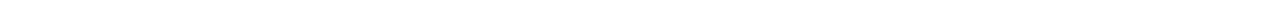
Fig. 7 Enhanced representation of target stimuli in a range of auditory Go/No-Go tasks. Each line of four panels represent the same analysis for all four tasks; statistics are given in order of appearance in the fi gure. a , e , i , m Projection onto the decoding axis determined during the sound period of trial- averaged reference (blue) and target (ref) activity during the passive (dark colors) and the engaged (light colors) sessions. A baseline value computed from spontaneous activity was subtracted for each neuron, so that the origin corresponds to the projection of spontaneous activity (shown by black line). Note that the target-driven activity is further from the baseline in the engaged state and the reference-driven activity is closer. The periods used to construct the decoding axis are shaded in gray. Error bars represent 1 std (cross-validation n = 400). b , f , j , n Index of target enhancement induced by task engagement based on projections using the decoding axis determined during the sound. In green, same index computed instead by giving the same weight to all units. The difference between the green and black curved indicates that the change in asymmetry induced by task engagement cannot be detected using the population averaged fi ring rate alone. Error bars represent 1 std (cross-validation n = 400). c , g , k , o Modulation index of each unit for spontaneous fi ring rate after exclusion of lick-related units. Error bars are 95% CI (one-sample two-sided Wilcoxon signed-rank test with mean 0, n = 277, zval = 6.35, p = 2.1e-10; n = 161, zval = 7.22, p = 5.4e-13; n = 99, zval = 1.01, p = 0.30; n = 520, zval = − 0.78, p = 0.47; *** p < 0.001). d , h , l , p Comparison of reference/target asymmetry for evoked responses in different states relative to different baselines given by passive or engaged spontaneous activity. Reference/target asymmetry is the difference of the distance of target and reference projected data to a given baseline. We examine three cases: (i) passive evoked responses, distances calculated relative to engaged spontaneous activity; (ii) engaged evoked responses, distances calculated relative to passive spontaneous activity; (iii) engaged evoked responses, distances calculated relative to engaged spontaneous activity. In all three cases, the engaged decoding axis was used for projections. Error bars represent 95% con fi dence intervals ( n = 400 cross-validations; p (col1,col3) = 0.29 and p (col2,col3) < 0.0025; p (col1,col3) = 0.38 and p (col2,col3) < 0.0025; p (col1,col3) < 0.0025 and p (col2,col3) = 0.16; p (col1,col3) < 0.0025 and p (col2,col3) = 0.92; ** p <